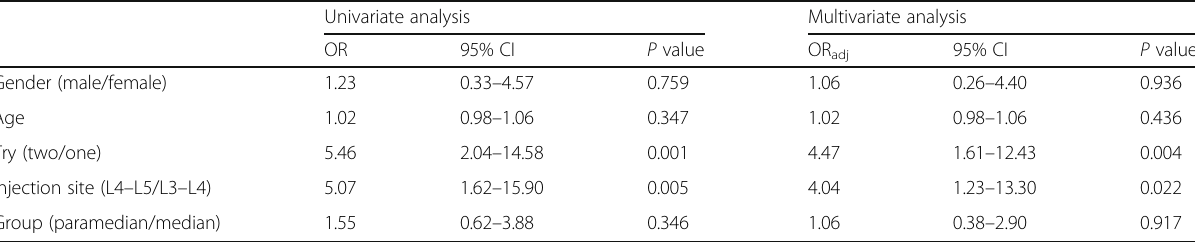
Table 5 Odds ratio of having low back pain at 72 h Univariate analysis Multivariate